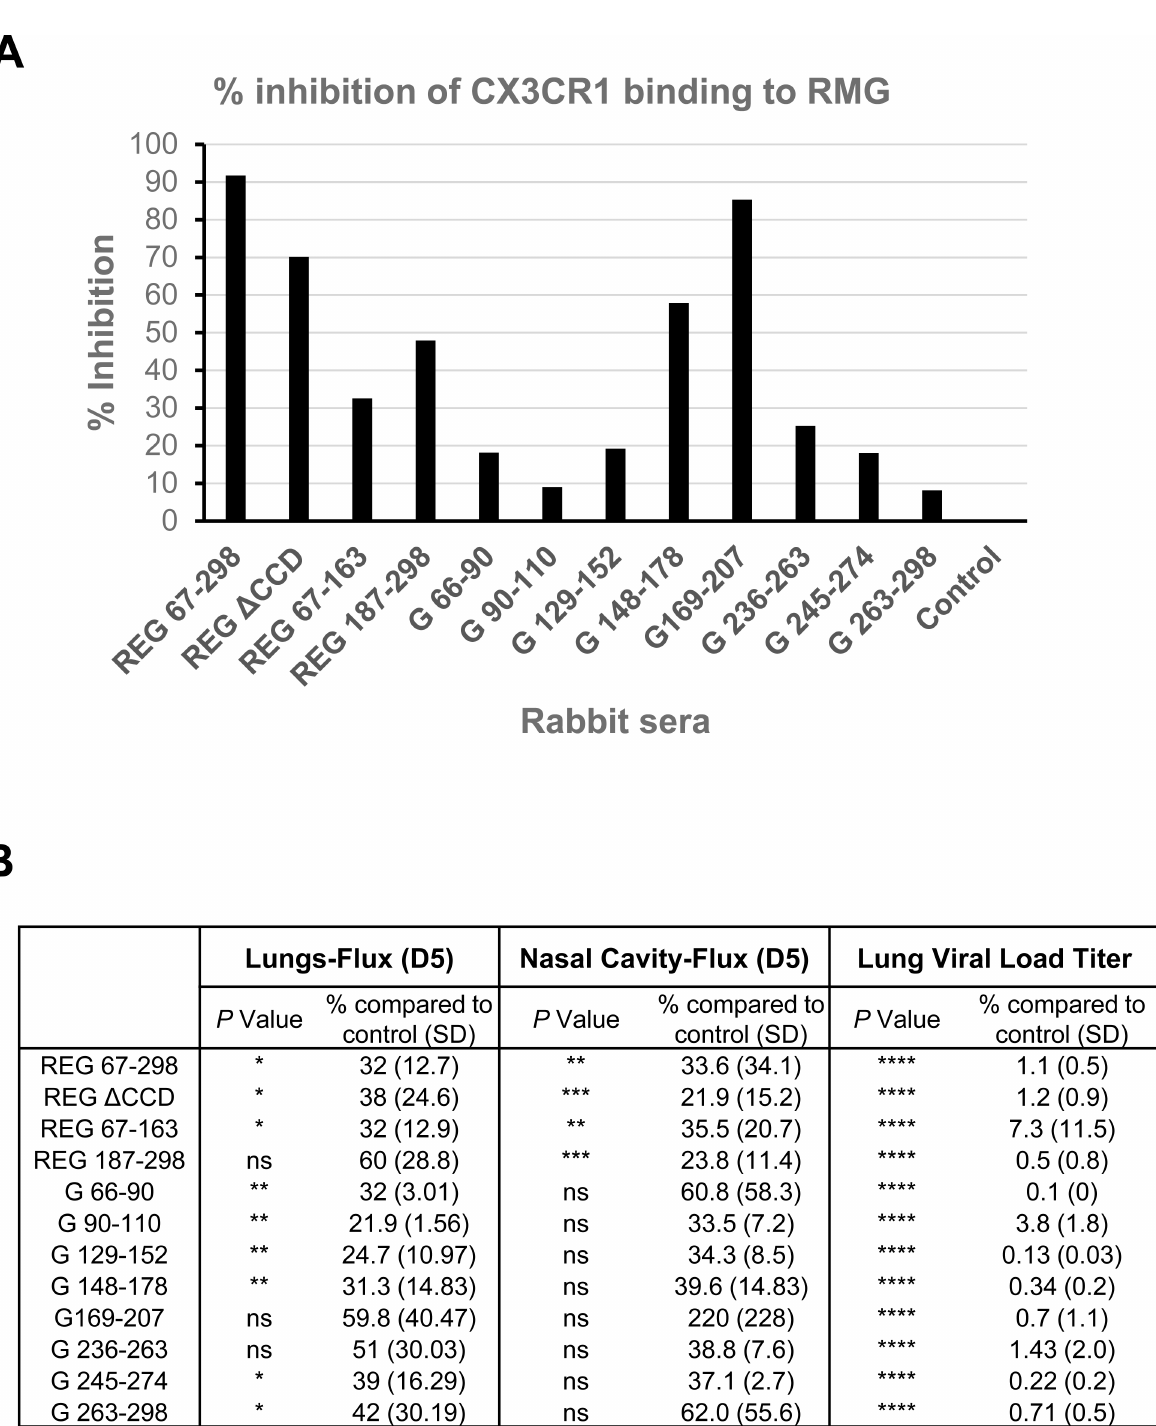
PLOS Pathogens| https://doi.org/10.1371/journal.ppat.1007262 August 24, 2018 15 /